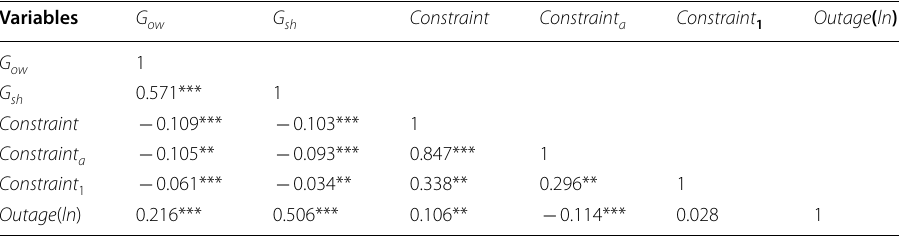
*, **, *** shows significance at 10%, 5% and 1%,